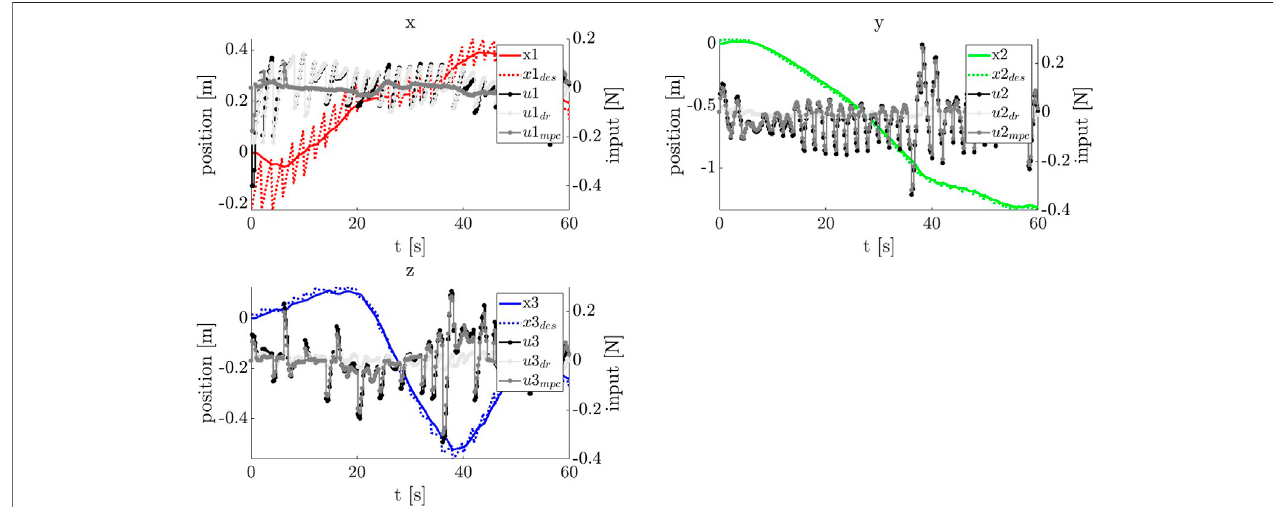
FIGURE 13 | The input and state histories for the robust controller tracking the online-updated reference trajectory (dashed). It is important to remember that the referencetrajectoryin thisscheme actually shifts in real-time asnewSLAM estimates ofthe trueTargetattitude, (cid:14) q T become available. Itispreciselythis stepwise shifting for which the tube robustness guarantee is produced. u dr indicates the disturbance rejection component, while u mpc indicates the nominal MPC component.